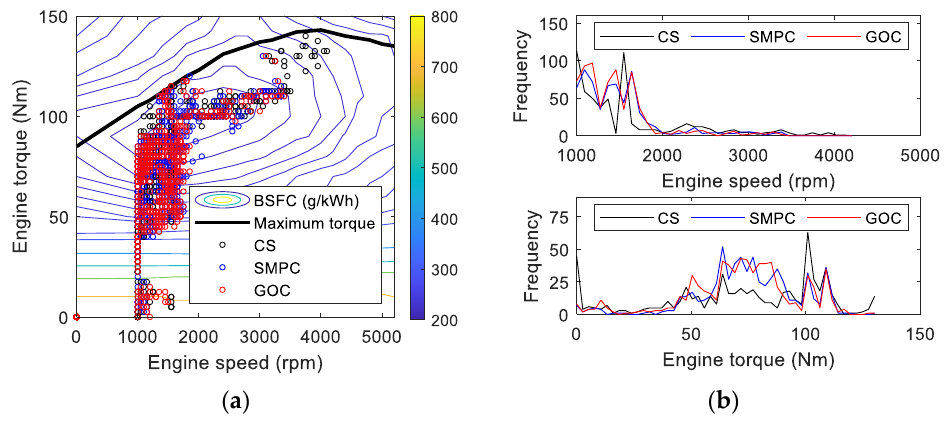
Figure 14. Engine results for the EC using different speed controllers: ( a ) engine-point distribution and ( b ) histogram of engine speed and torque.